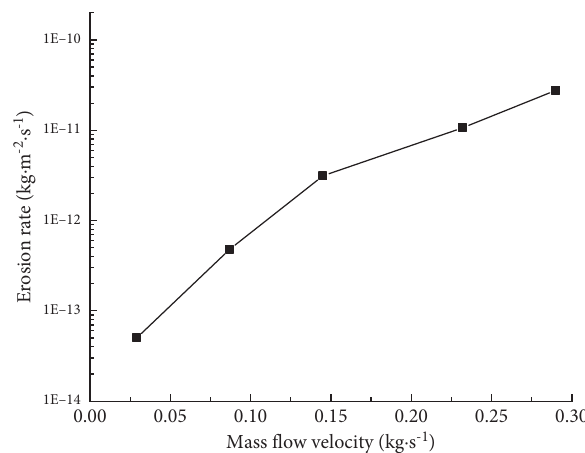
Figure 14: Effect of different mass flow velocities on erosion